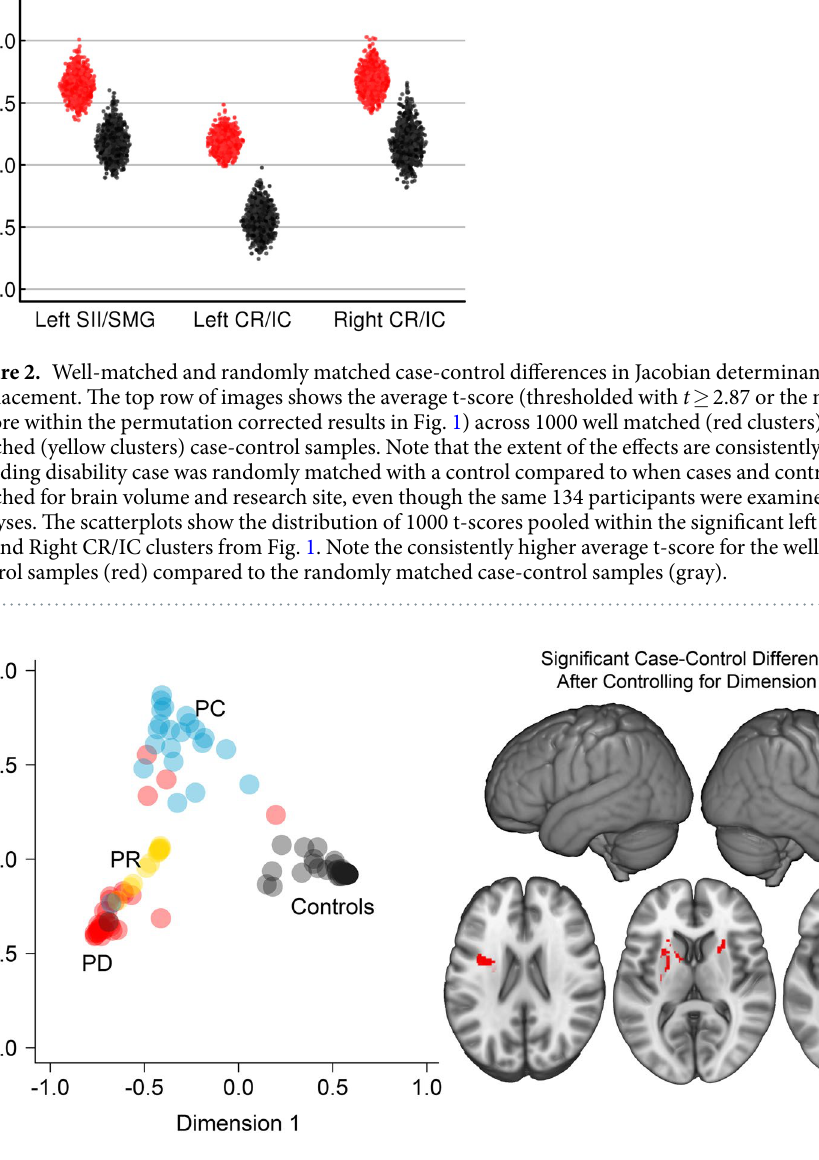
Figure 3. Multidimensional scaling demonstrates the extent to which reading disability profiles differ from controls. Left plot: Across participants, a larger Dimension 1 value was significantly associated with higher Verbal Comprehension, Word Attack, Word Identification, Passage Comprehension, and Rapid Naming performance ( p s < 0.001). Dimension 2 was negatively associated with Verbal Comprehension ( r (132) = − 0.21, p = 0.02) and negatively associated with Passage Comprehension ( r (132) = − 0.17, p = 0.05). The color of the symbols refers to the expert-rater classification (PD: Poor Decoder; PR: Generally Poor Reader; PC: Poor Comprehender) and therefore shows which participants were inconsistently classified by the Random Forest algorithm. Right brain images: The subcortical effects, but not the left SII/SMG effect, shown in Fig. 1 remain significant after controlling for matched-pair differences in Dimension 2. This result is consistent with Table 1 showing that Poor Comprehenders, which largely affect Dimension 2, exhibited pronounced left SII/SMG differences between cases and controls. There were not significant effects after controlling for dimension